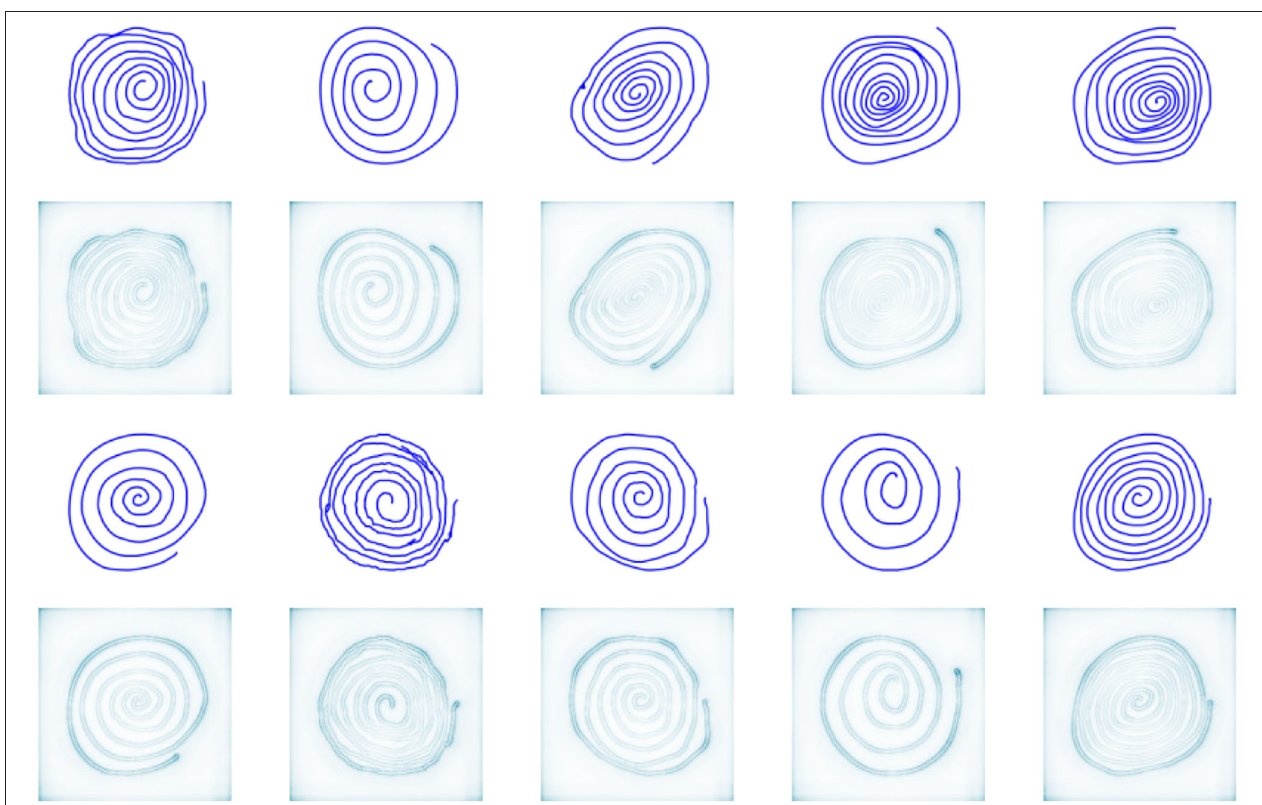
FIGURE 4 | Relevance maps for ten Archimedean spirals (two random samples from each dataset are